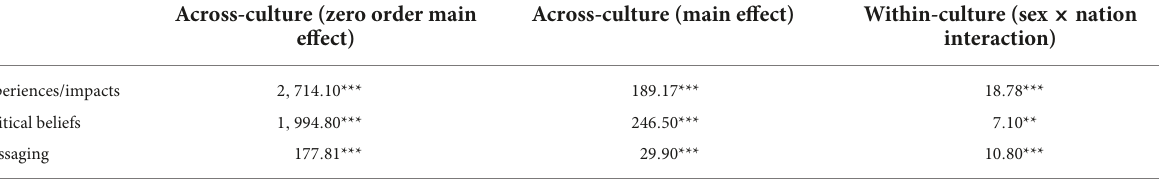
TABLE 11 Linear mixed models: comparing across-culture versus within-culture effects for PAIR predictions of perceived threat. Across-culture (zero order main effect)